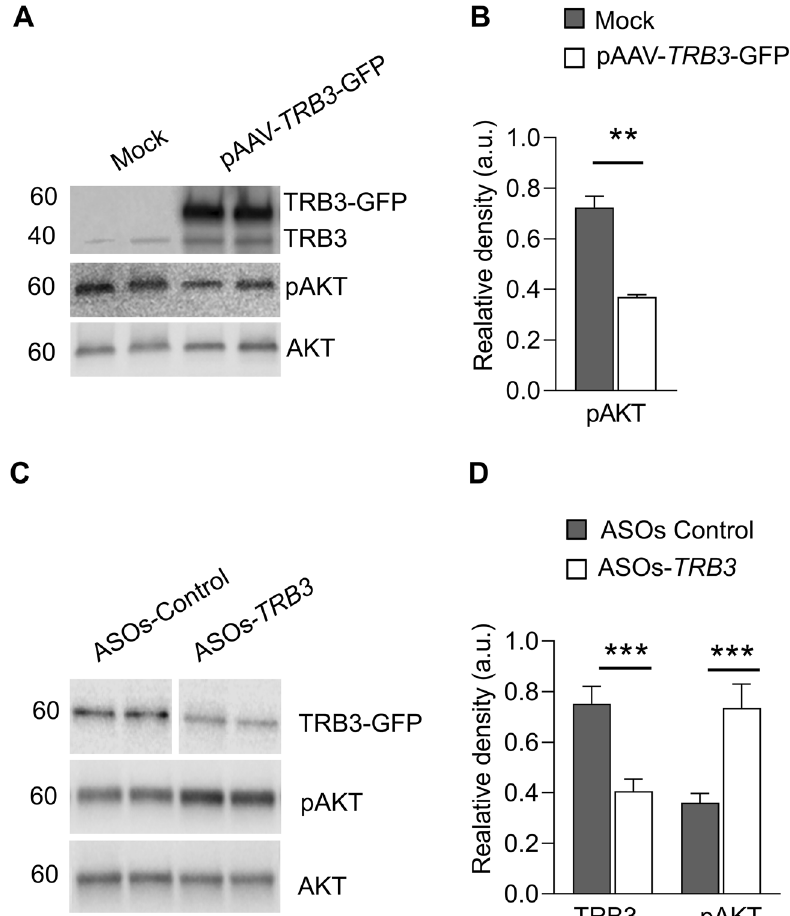
separated running polyacrylamide gel. Images of western blots stained with anti-TRB3 and anti-pAKT Ser473 antibodies are shown. B Quantitation of p-AKT normalized to AKT is shown. About a 50% reduction in p-AKT level was observed ( n = 4). C MIO-M1 cells were transfected with AAV-CAG-TRB3-GFP plasmid in addition to control and anti-TRB3 ASOs for 48 h. TRB3, p-AKT, and AKT were detected in the protein extracts. D An analysis of densitometry of TRB3 and pAKT Ser473 bands normalized to the bands for β -actin and AKT, respectively, is shown ( n = 4). Data are shown as mean ± SEM; a.u. = arbitrary units; ** p < 0.01, *** p <